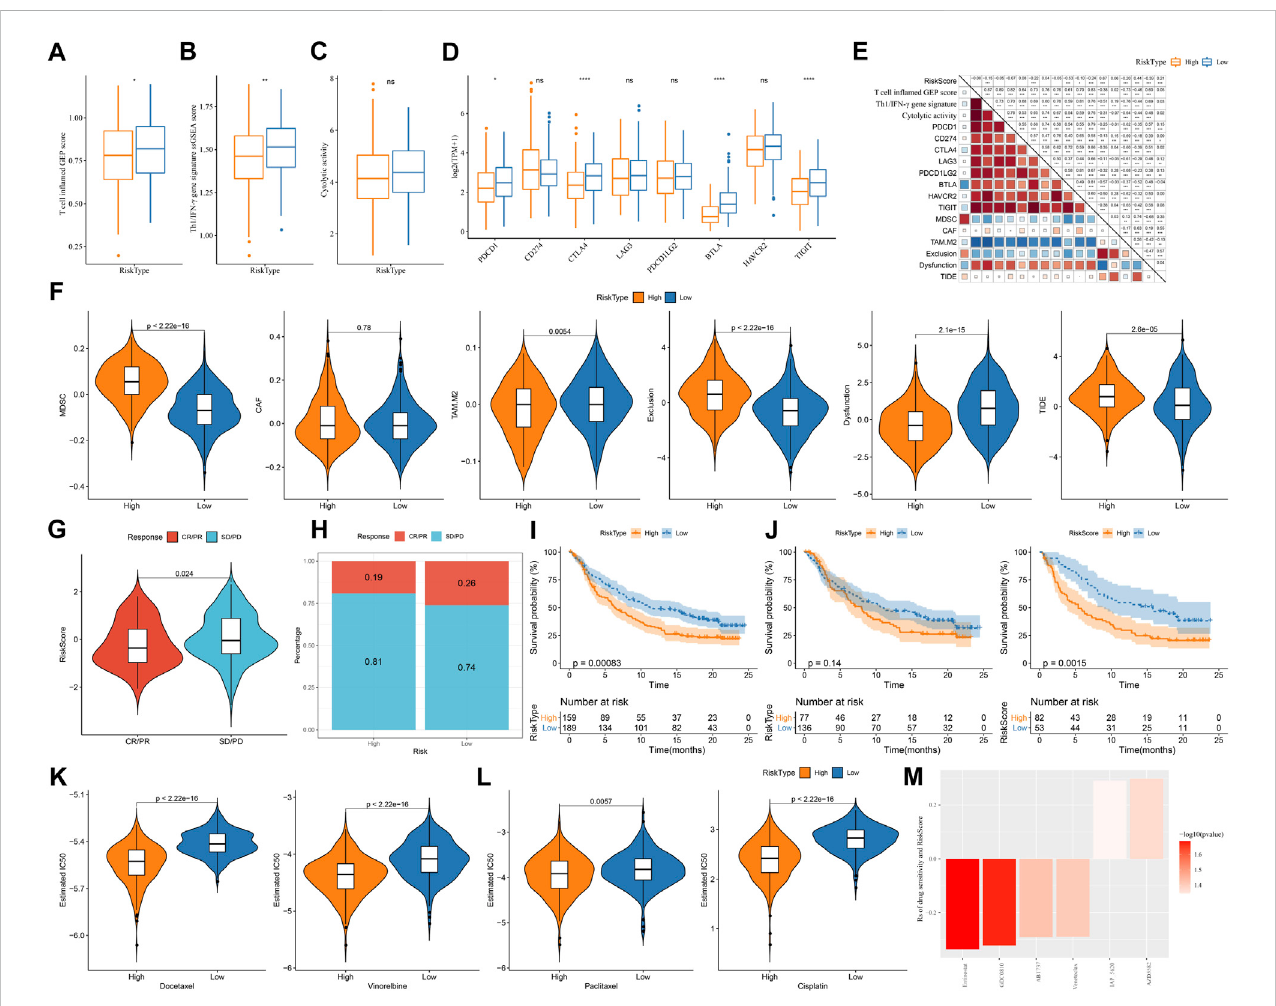
FIGURE 9 The predicted response to immunotherapy and chemotherapeutic drugs analyzed in TCGA and IMvigor210 datasets (A – C) The score of T cell in fl amed GEP, Th1/IFN- γ signature, and cytolytic activity in two risk groups (D) The expression of immune checkpoint genes in two risk groups (E) TIDE analysis calculated theenrichmentofimmunosuppressive cells, Tcell exclusion, Tcell dysfunction,and TIDE score intworiskgroups (F) Correlationofrisk score with immunotherapy-related indicators (G) The risk score in CR/PR and SD/PD groups in IMvigor210 dataset (H) The proportion of CR/PR and SD/PD in two risk groups in IMvigor210 dataset (I – K) Survival plot of high-risk and low-risk groups in all stages (I) , early stage (I+ Ⅱ ) (J) , and late stage ( Ⅲ + Ⅳ ) (K) in IMvigor210 dataset (L) The estimated IC50 of four chemotherapeutic drugs in two risk groups (M) Drug sensitivity of potential drugs in the relation to the risk score. Rs < 0 indicates drug sensitivity and Rs > 0 indicates drug